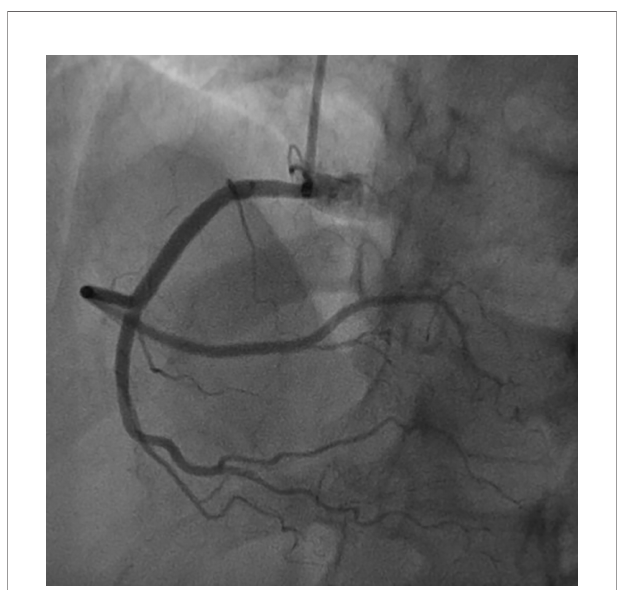
FIGURE 3 | Coronary angiography with complete resolution of the thrombus formerly